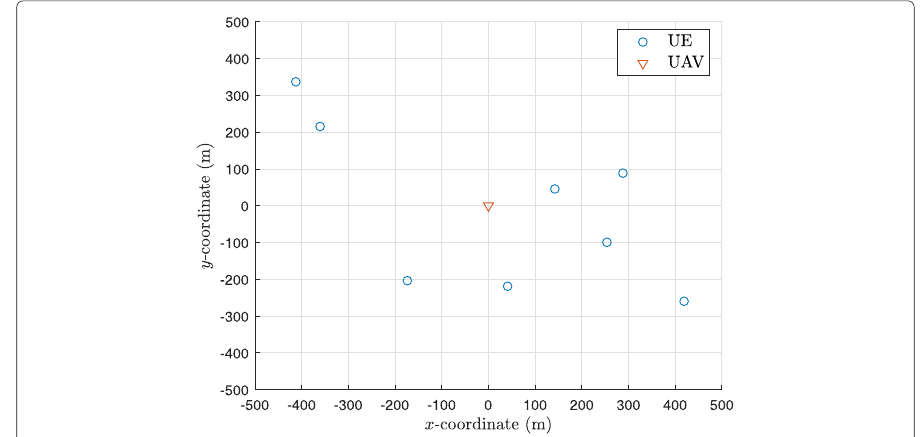
Fig. 2 The locations of the UEs and the UAV in x - y